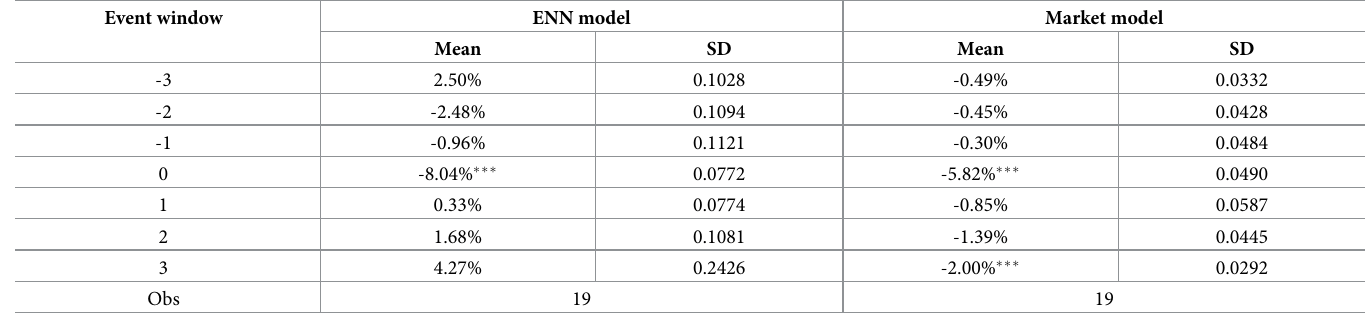
Table 6. ARs of the firms without other material